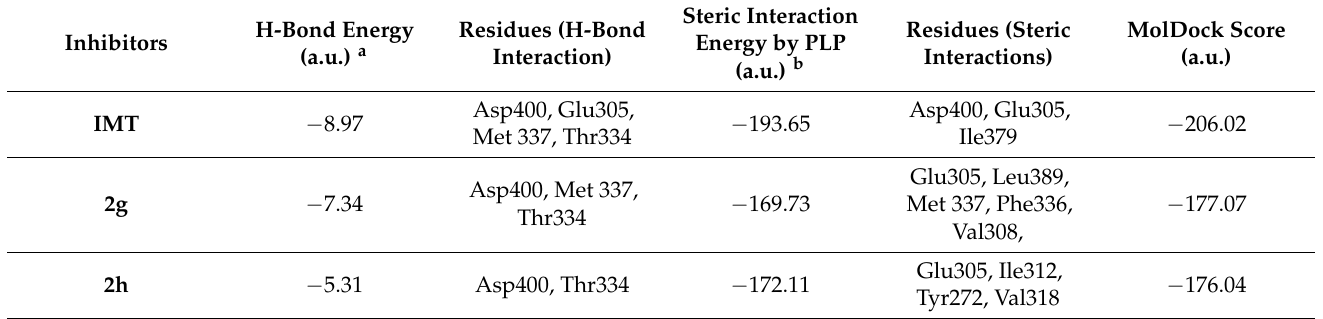
Table 2. Summary of interactions between the 2g , 2h , and IMT inhibitors and the tyrosine kinase BCR-ABL1